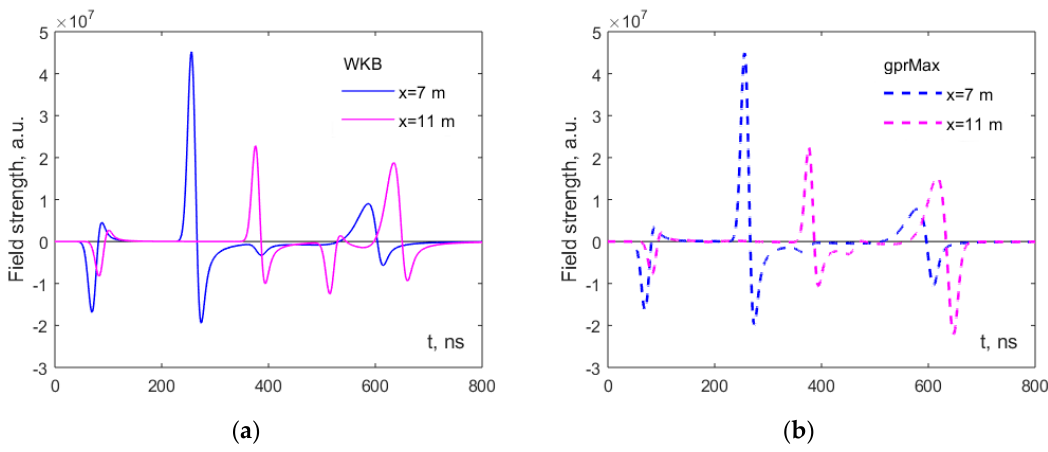
Figure 6. A-scans simulated with: ( a ) our coupled WKB method (solid lines); and ( b ) gprMax (dashed lines), for larger distances between transmitter and receiver.